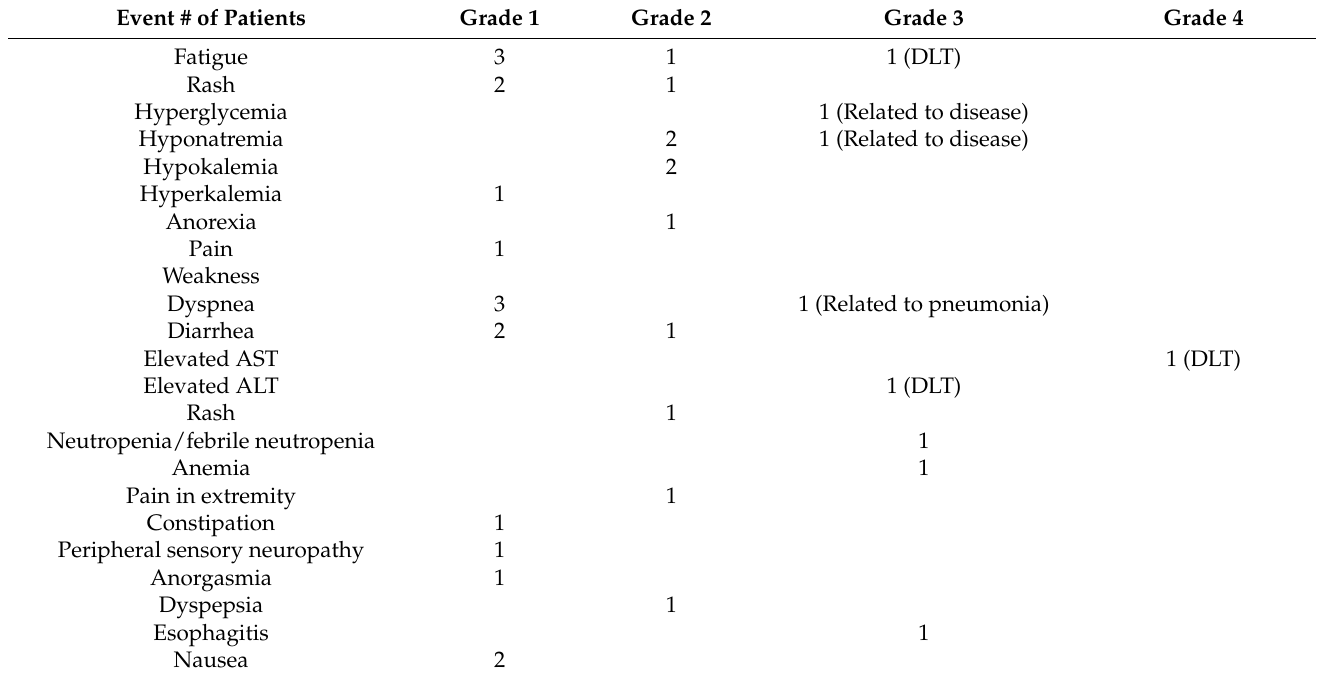
Table 3. Persistent toxicities or Grade ≥ 3 serious adverse events (all reported events). DLT related to the study drug was reported within the first 28 days.